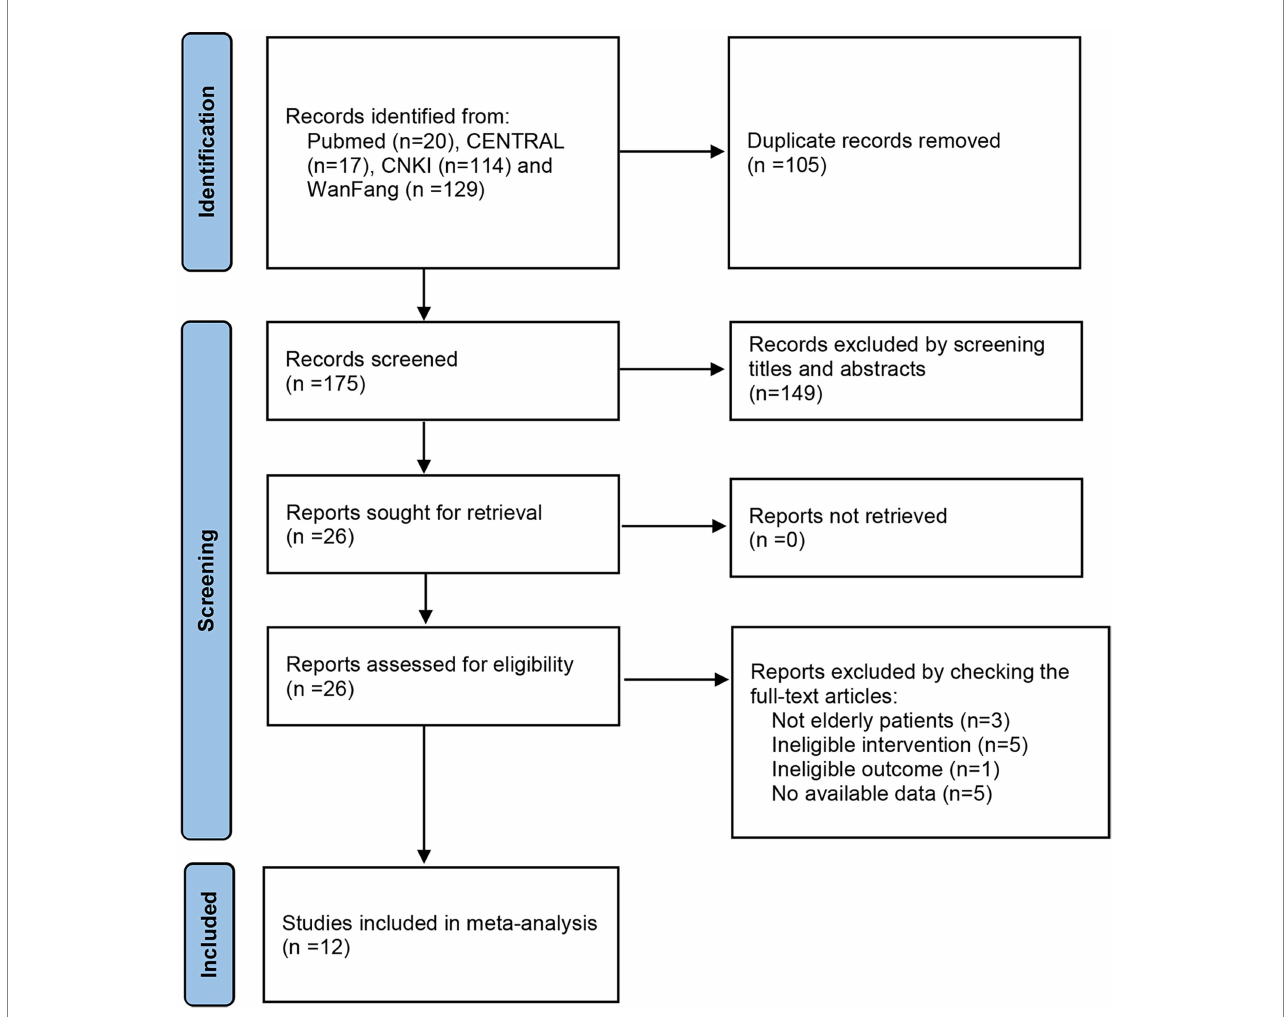
FIGURE 1 Flow diagram of the study selection